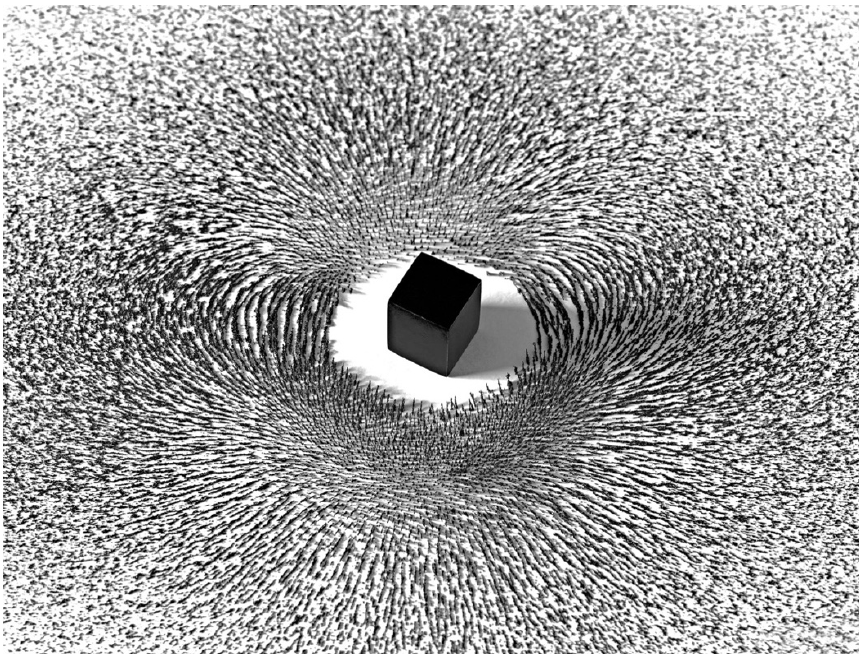
Figure 9. Magnetism IV , photogravure etching, Ahmet Mater, 2011. © Ahmet Mater